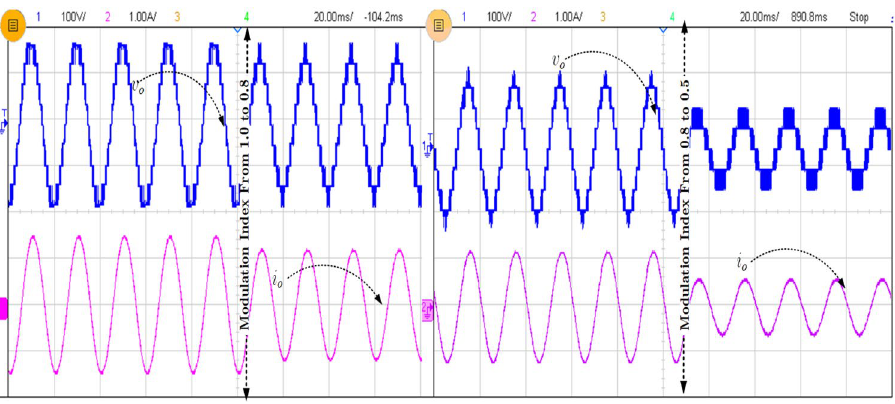
Figure 8. Experimental results of modulation index variation from 1.0 to